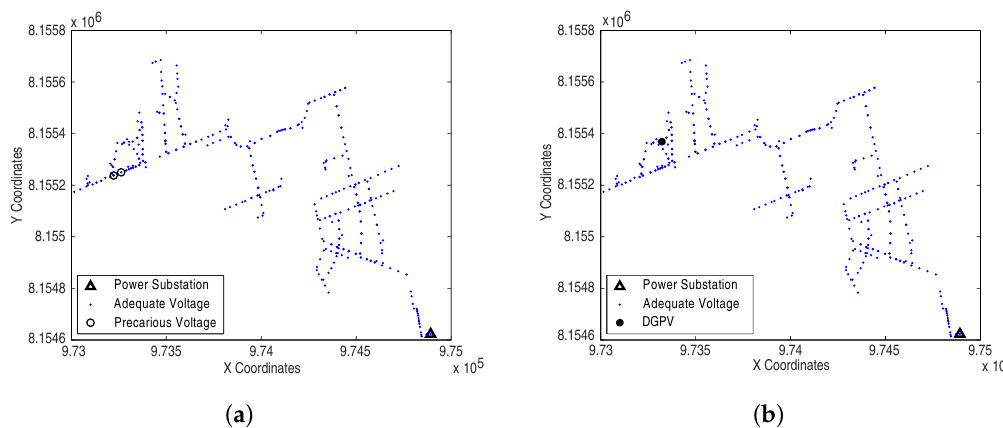
Figure 11. Scenario 1: ( a ) voltage rating before Distributed Generation Photovoltaic (DGPV) allocation and ( b ) voltage rating after DGPV allocation.